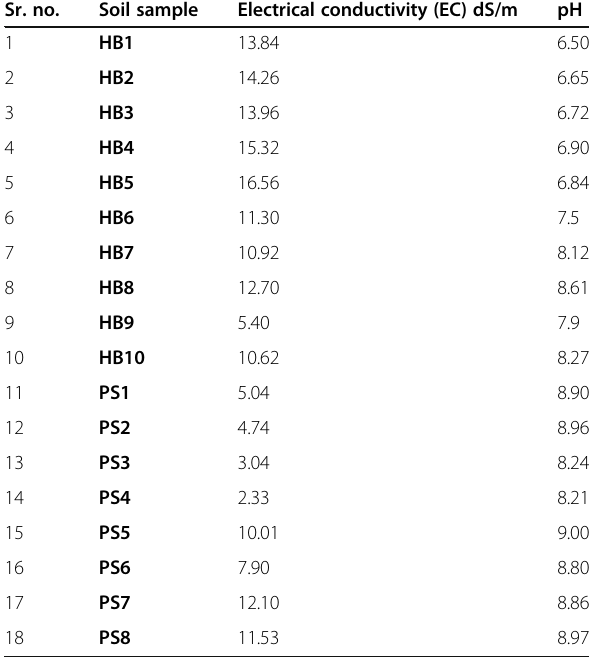
Table 1 Soil samples collected from Jhajjar (serial nos. 1 to 10) and Panipat districts (serial nos. 11 – 18) of Haryana, India along with their EC and pH analysis Sr.